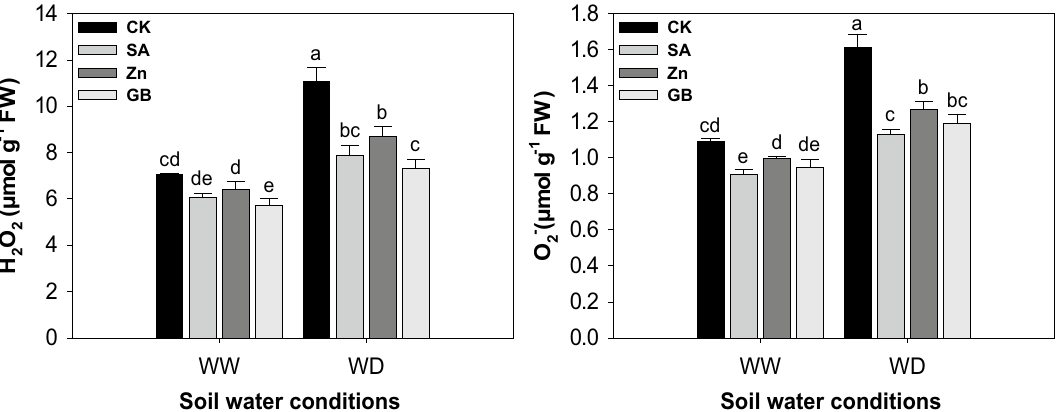
Figure 4. Effect of soil water conditions and foliar treatments on hydrogen peroxide (H 2 O 2 ) and superoxide anion (O 2− ) contents. Every column in each graph represents the mean (± SE) of three replicates. Different letters above columns indicate that means are different at 95% confidence level. WW, well-watered; WD, water- deficient; CK, control (double distilled water); SA, salicylic acid; Zn, Zinc; GB, Glycine betaine.